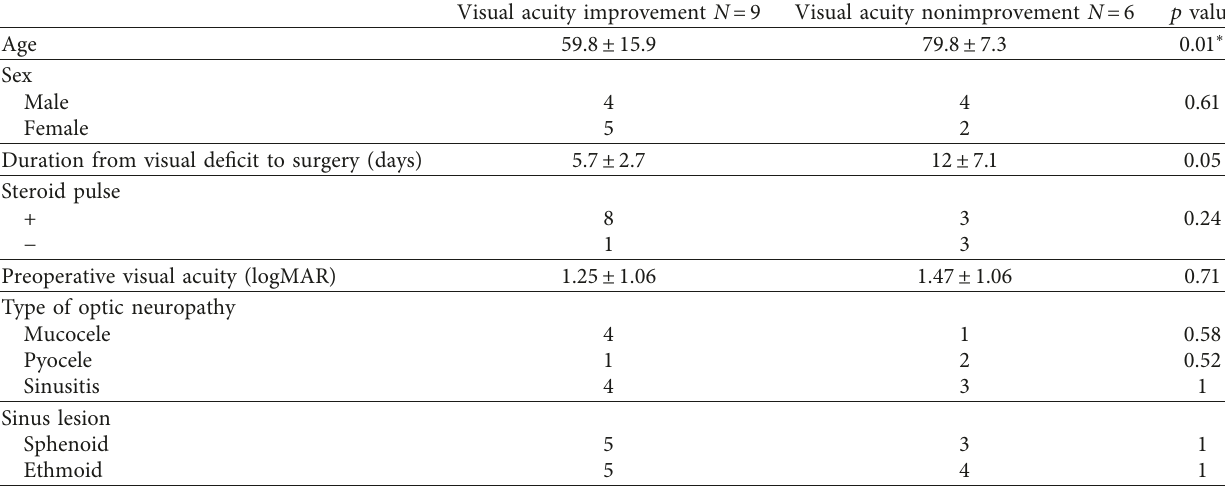
Table 2: Comparison of the ratio of visual prognostic factors in the visual acuity improvement group and the nonimprovement group by